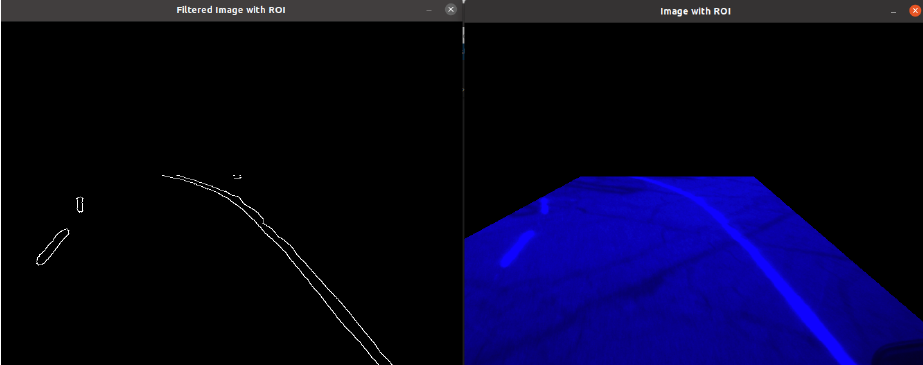
Figure 20. The above figure indicates the ROI cropping performed. Since both white lines are ideally required for this algorithm, the ROI is symmetrical on both